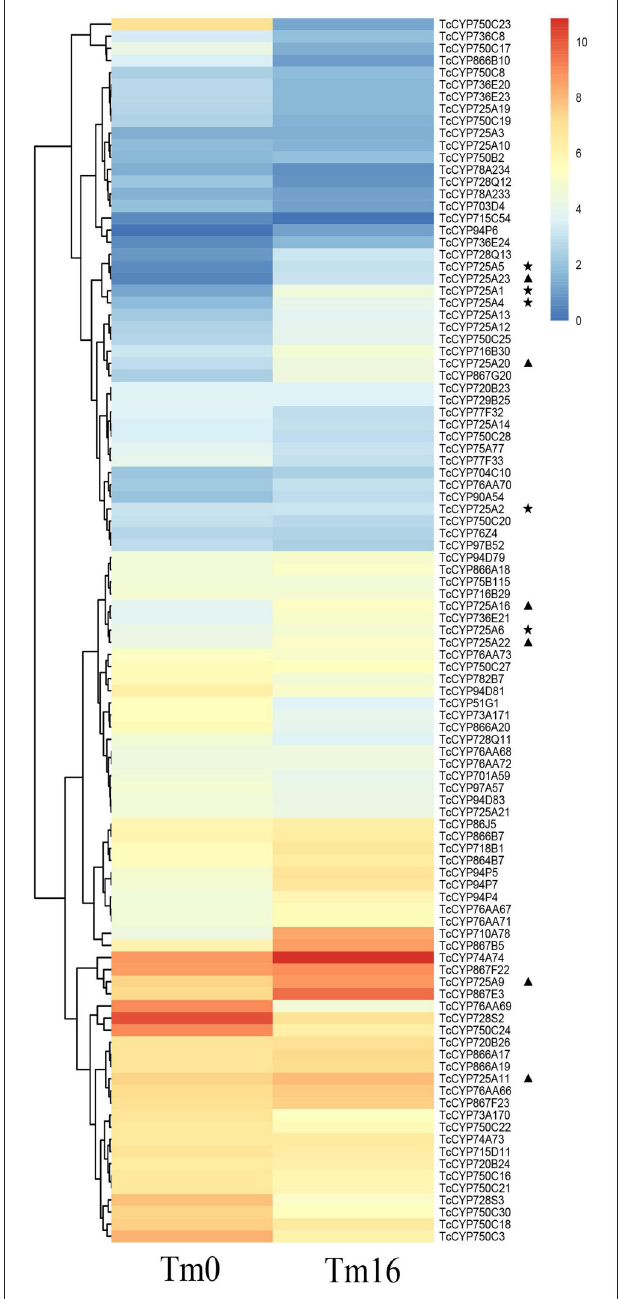
FIGURE 5 | Expression pattern of T. chinensis CYP450s under MeJA elicitationin according to the analysis of RNA-Seq dataset. The color scale shows the expression quantity (red, high expression; blue, low expression). Heat map was created using HemI. Heatmap Illustrator v1.0. “ ⋆ ” indicates the known taxoid hydroxylase genes, and “ N ” indicates the candidate